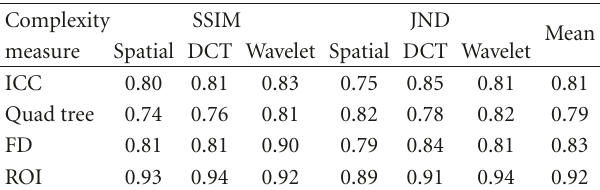
Table 2: The correlation coe ffi cient between complexity measures (ICC, Quad tree, Fractal Dimension (FD) and ROI) and image qual- ity measures (SSIM and JND) according to di ff erent watermarking methods (Spatial, DCT and Wavelet).